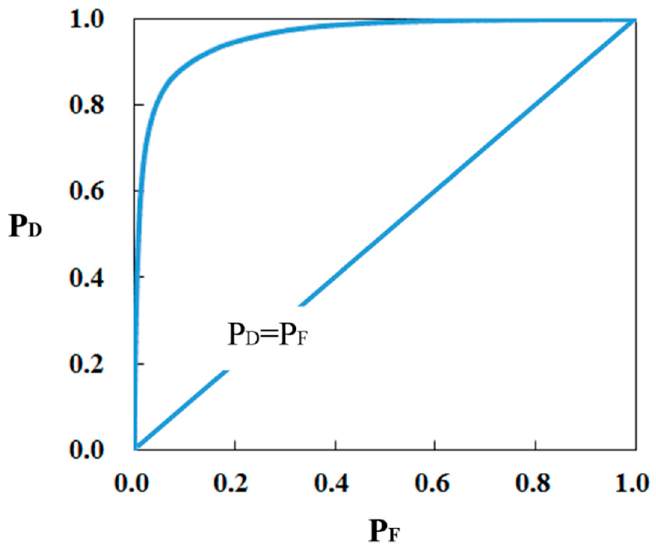
Figure 13. ROC Curve.